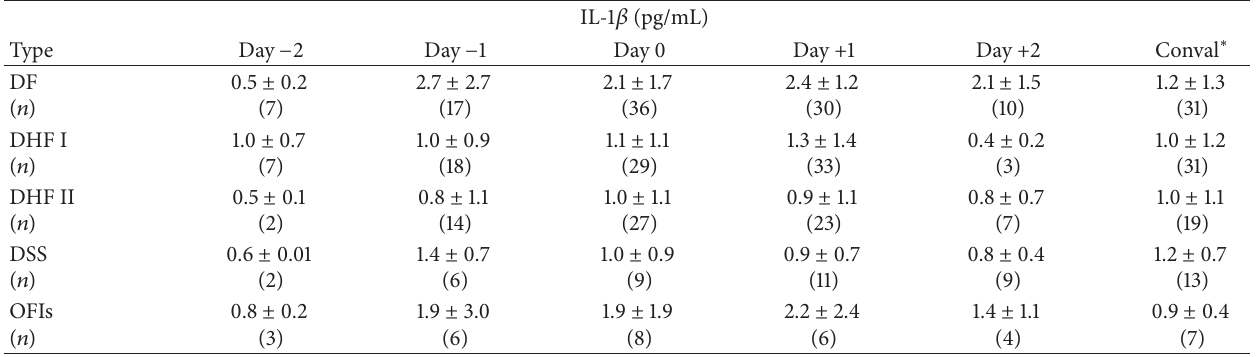
Table 7: Mean ± SD of the level of interleukin-1 beta (IL-1 𝛽 ) in patients with DF, DHF grades I and II, DSS, and OFIs patients, followed by the day of illness related to fever.